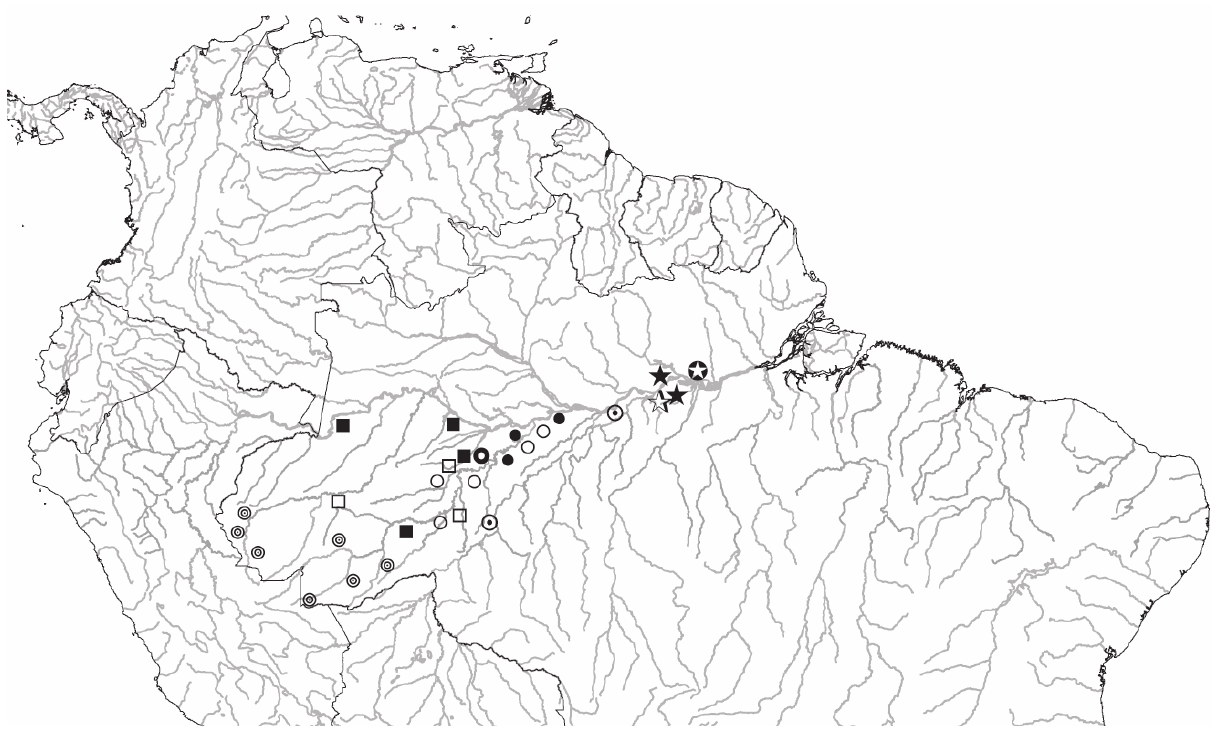
Figure 1. Distribution of relevant specimens for the synonymization of C. procurvoides successor into C. trochilirostris notabilis . ( Stars ) Localities of specimens classified as C. trochilirostris snethlageae in the present study (dark stars), including the holotype (white star),